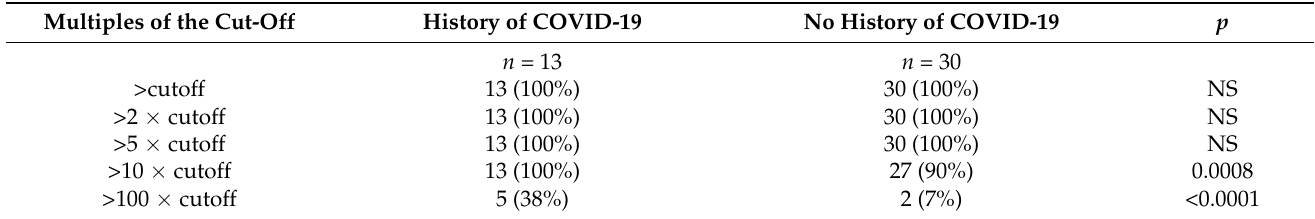
Table 2. Prevalence of anti-S-RBD antibodies at the levels exceeding multiples of the cut-off determined for the positive result in individuals with and without a history of clinical COVID-19; NS—not